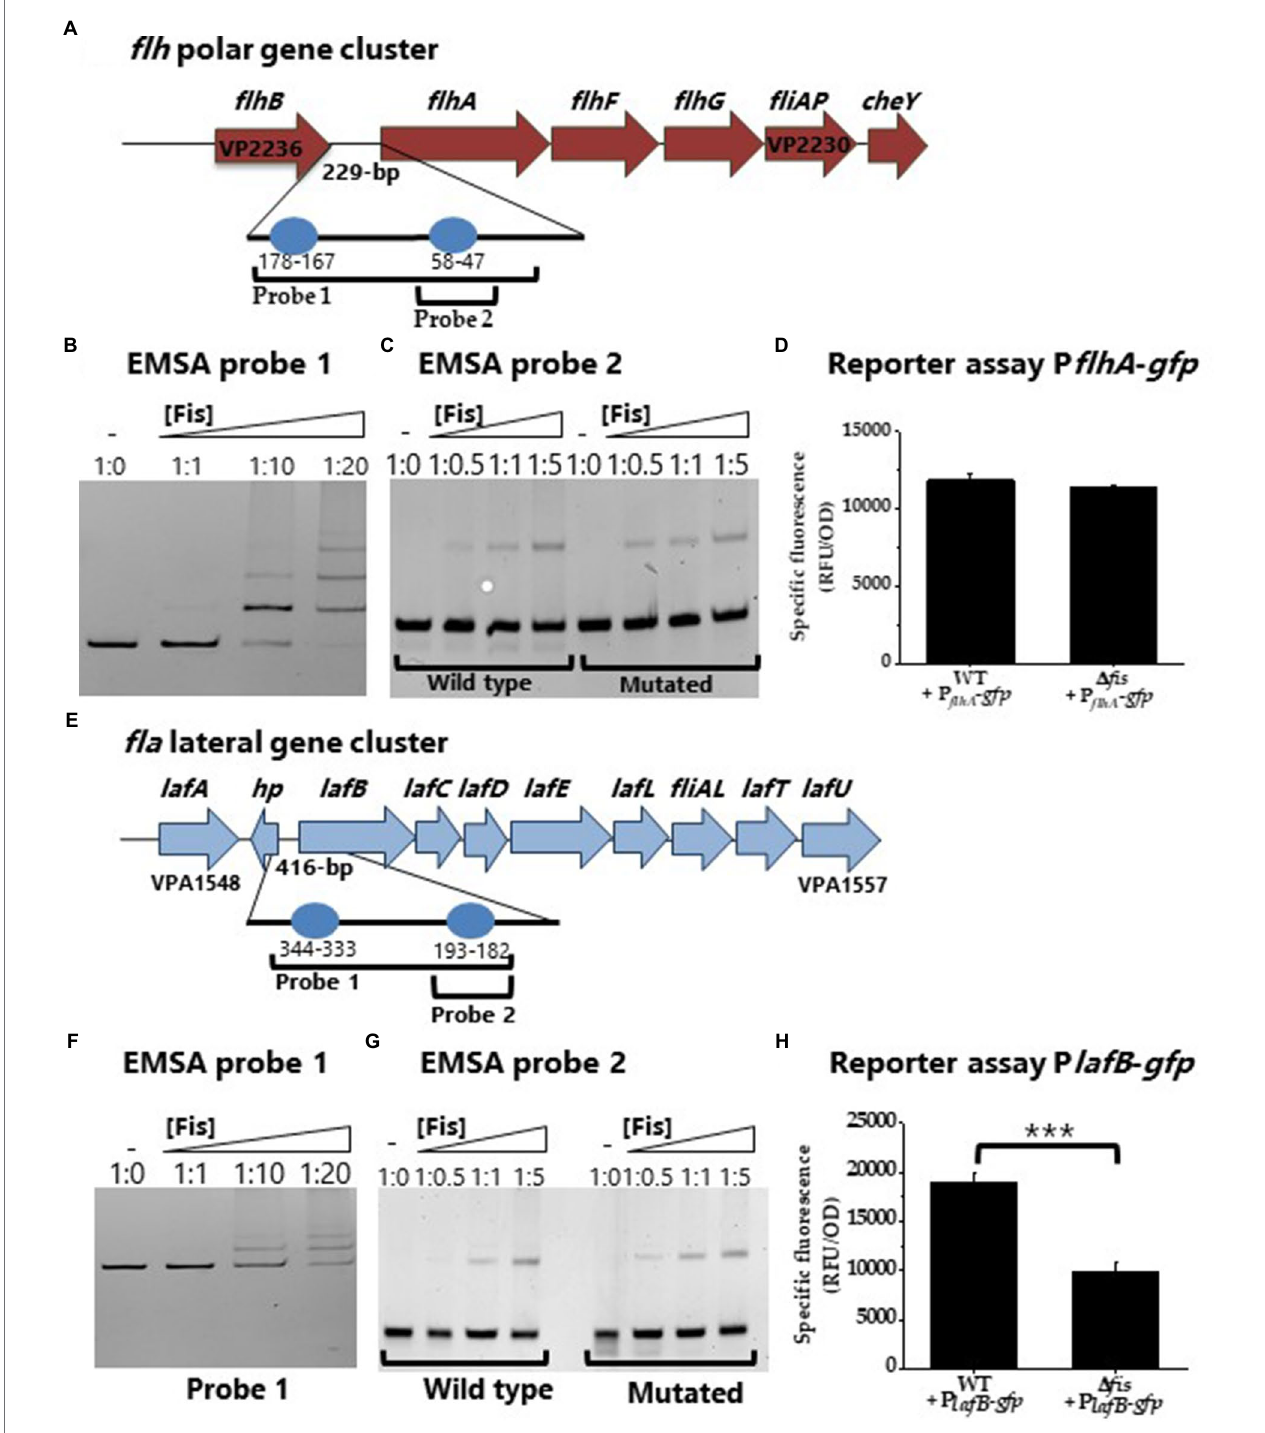
FIGURE 5 | Regulation of lateral flagella biosynthesis by Fis. (A) Regulatory region of polar flagellum flh genes with putative Fis binding sites (BS) depicted as blue circles. (B) EMSA of Fis bound to P flhA in a concentration dependent manner. DNA: protein ratios are as follows: 10, 1:1, 1:10, 1:20. (C) Probe 2 containing a single Fis BS (WT) was mutated. DNA: protein ratios are as follows: 0, 1:0.5, 1:1, 1:5. (D) Transcriptional GFP reporter assay of P flhA - gfp in the Δ fis mutant relative to wild type. (E) Regulatory region of lateral flagellum laf genes with putative Fis binding sites. (F) EMSA of Fis bound to P laf DNA probe. (G) Probe 2 containing a single Fis BS and a mutated probe 2 Fis BS. DNA: protein ratios are as follows: 0, 1:0.5, 1:1, 1:5. (H) Transcriptional GFP reporter assay of P lafB - gfp between wild type and Δ fis (*** p <